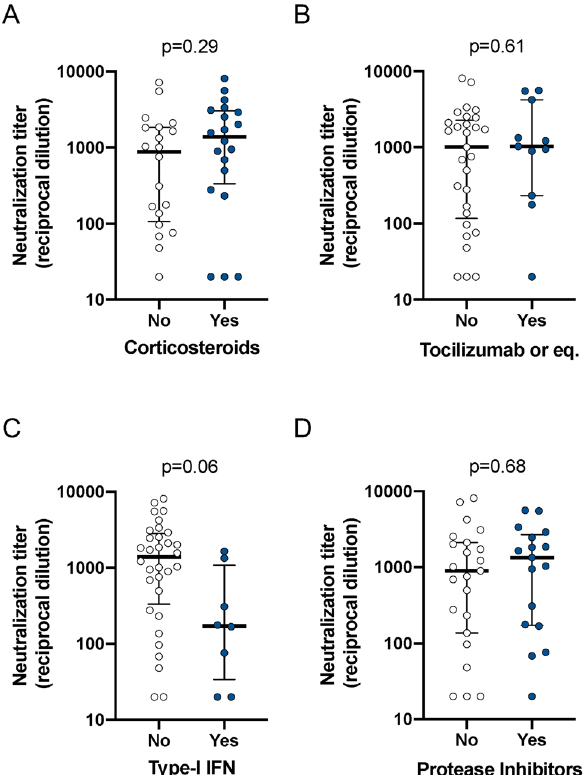
Figure 4. Effect of treatment. Maximal neutralization titers from hospitalized participants (n = 40) were analyzed according to the indicated treatments. Individual values, median and interquartile boxes (25–75) are indicated. P -values for Mann–Whitney tests are